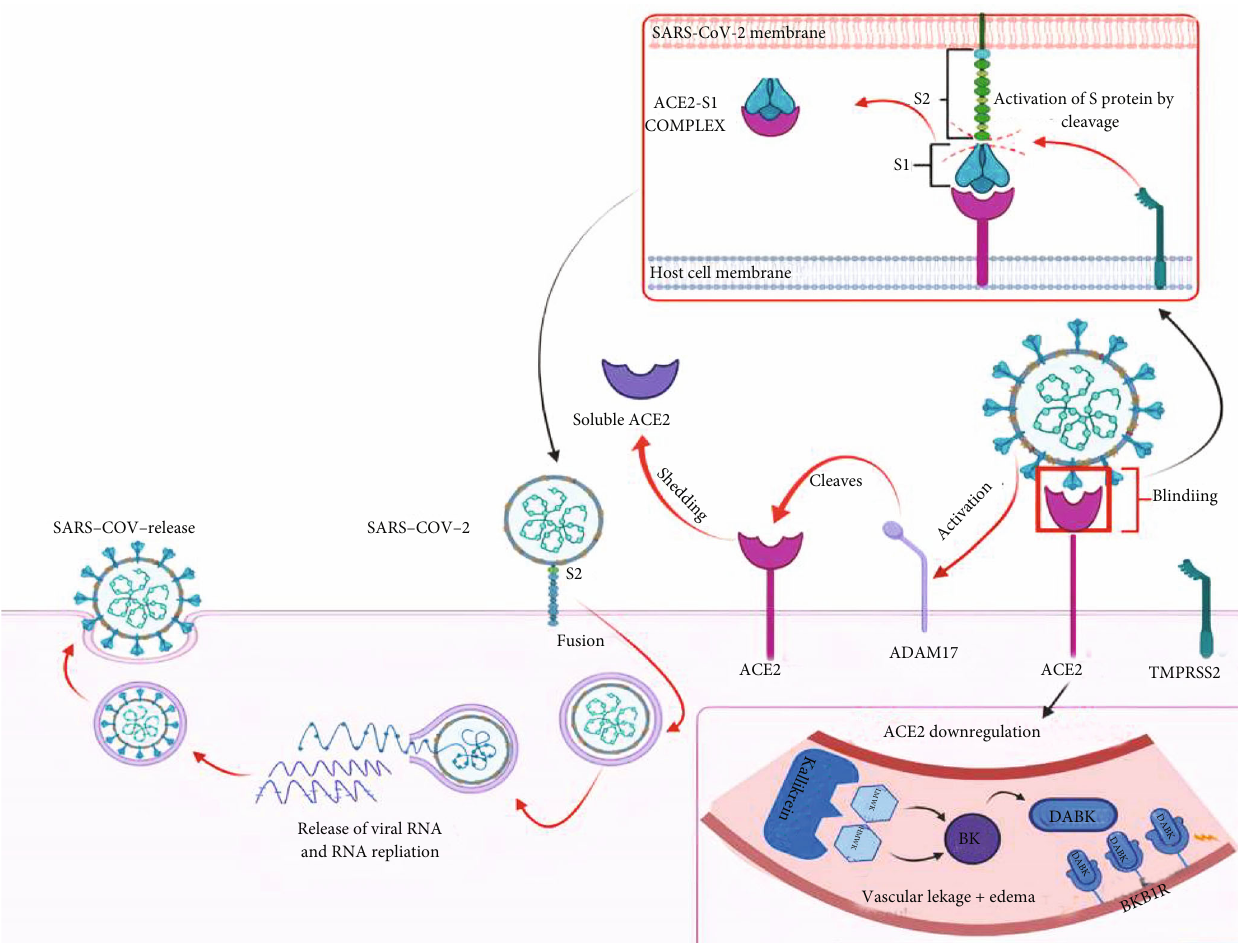
Figure 3: Pathogenesis of COVID-19 through bradykinin